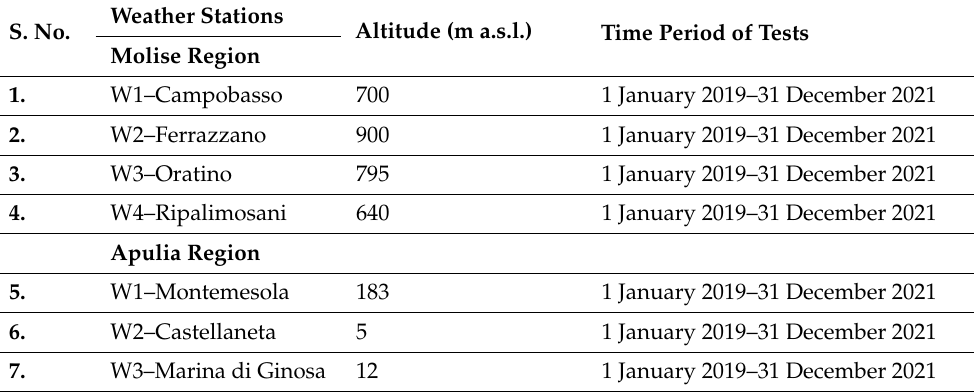
Table 2. Details of the weather stations where tests were